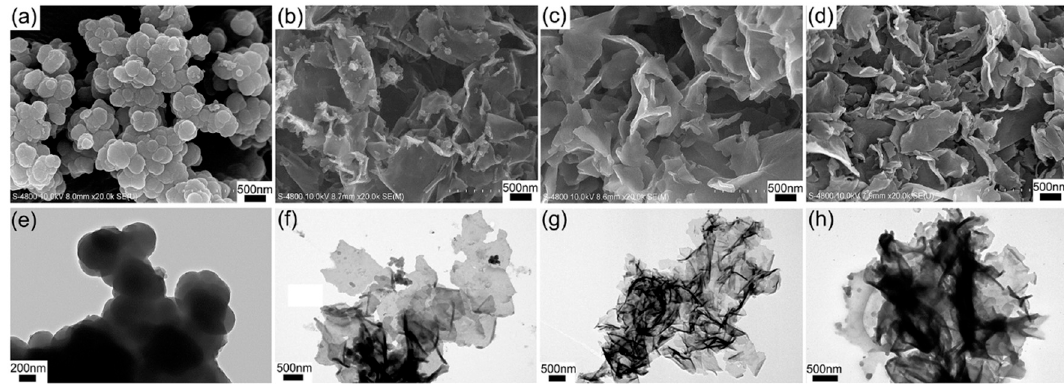
Figure 7. SEM and TEM images of PPy ( a , e ); PPy/rGO-5 ( b , f ); PPy/RGO-10 ( c , g ); and PPy/RGO-15 ( d , h ). Reproduced with permission from[68]. Elsevier (2018). Reproduced with permission from [68]. Elsevier